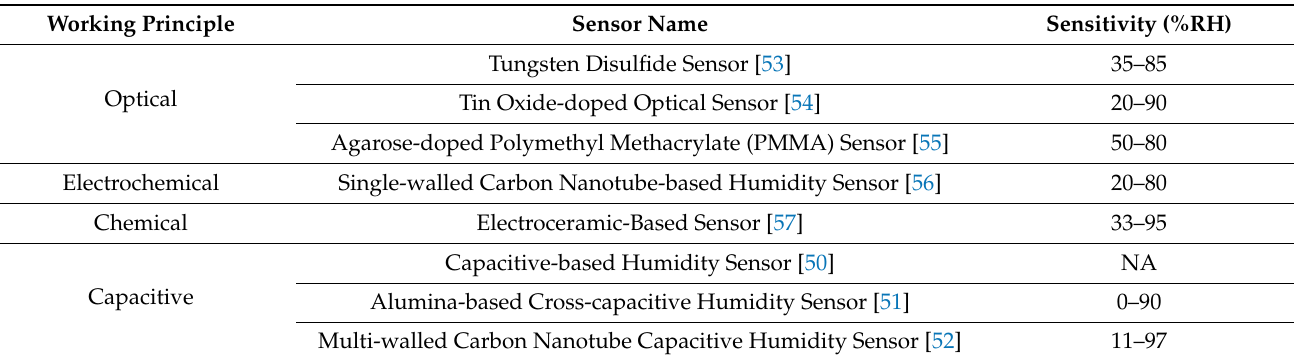
Table 3. Comparison of Humidity